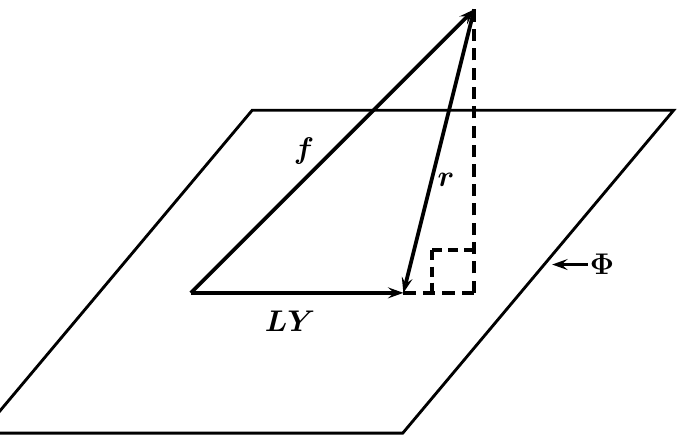
Figure 1. Geometry of Galerkin